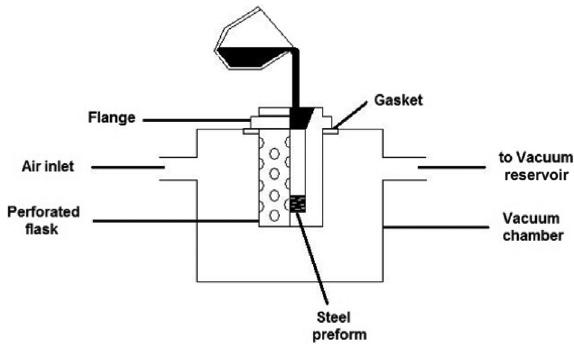
Figure 1: Casting process used in this study.